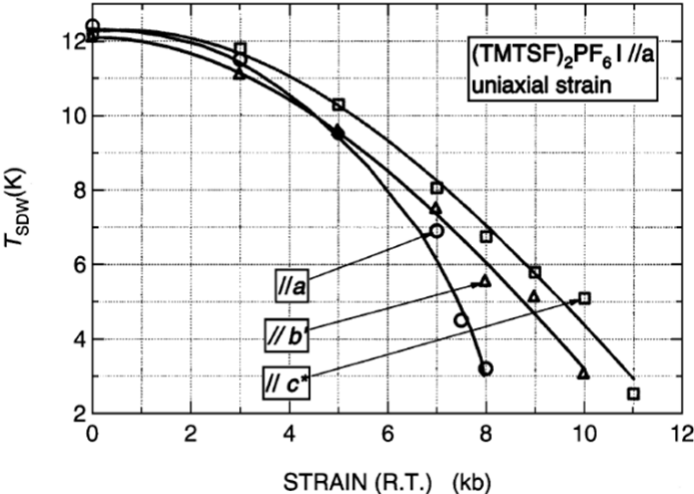
Figure 4. Temperature-Pressure phase diagram of SDW (left-bottom region of the lines) PF [52]. Reproduced with permission from and metal in (TMTSF) 2 6